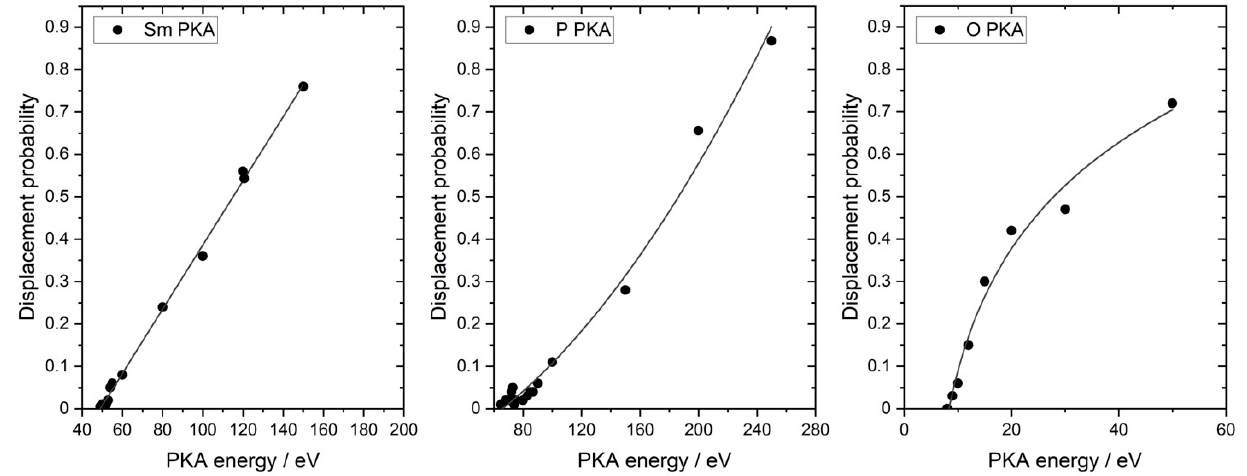
Figure 5. Simulated displacement probabilities of Sm, P, and O PKA in monazite-structured SmPO 4 as function of PKA energy at T = 300 K; the relative error in the data is estimated at ±5%.